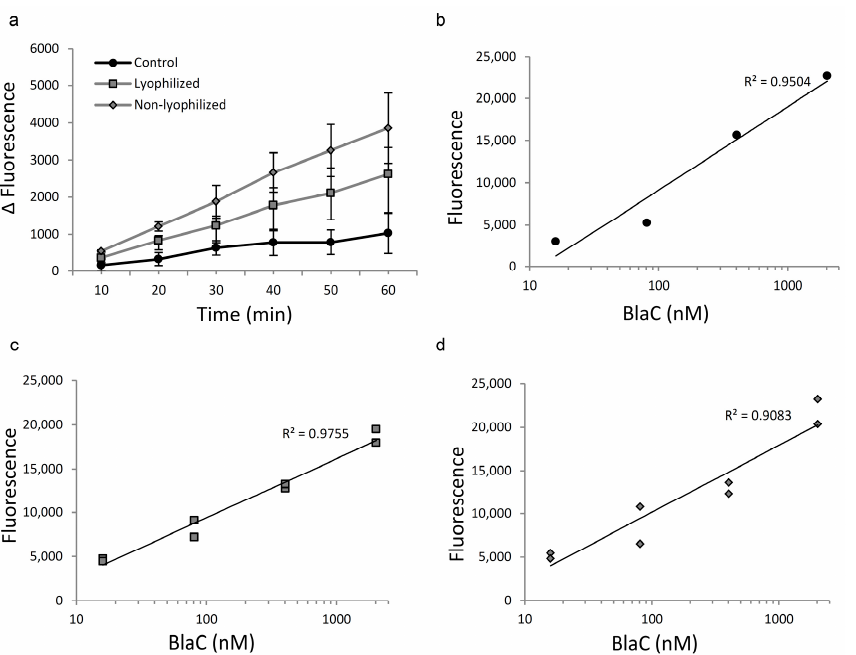
Figure 7. Albumin depletion of REFtb reaction buffer with Blue Sepharose significantly improves fluorescence levels compared to the buffer without albumin and Blue Sehparose. Comparison of the fluorescent signal in the product of CDG-3 cleavage using buffers after five cycles of albumin extraction with lyophilized and non-lyophilized Blue Sepharose. Albumin-free buffer served as a control. ( a )—Kinetics of the reaction with 16 um BlaC and CDG-3 substrate; ( b )—Linear relationship between BlaC concentration and fluorescence of the product of CDG-3 cleavage in the control; ( c )—buffer treated with lyophilized Blue Sepharose and ( d )—buffer treated with non-lyophilized Blue